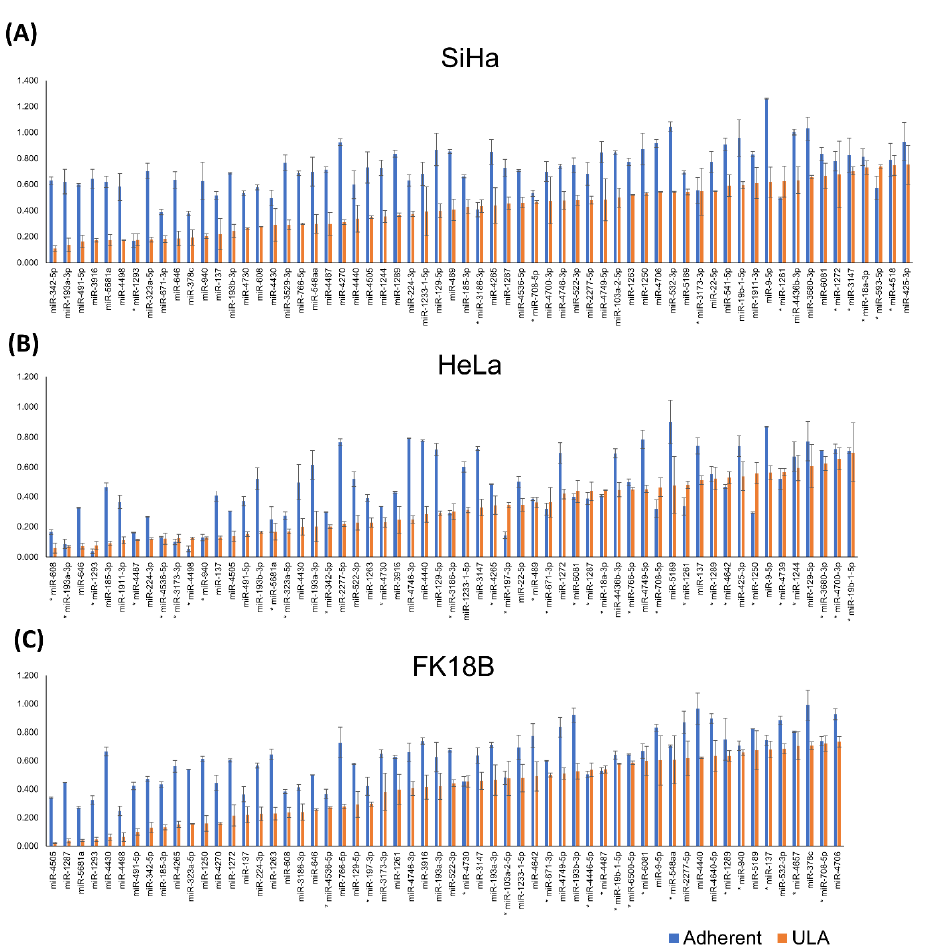
Figure 3. Validated miRNA mimics reducing growth on ULA plates. Cell viability results in adherent (blue) and ULA (orange) plates of validated miRNAs in SiHa ( A ), HeLa ( B ), and FK18B ( C ) cells. miRNAs annotated with * show no difference between adherent and ULA according to the set threshold. miRNAs without * show higher growth reduction in ULA plates than adherent plates and are referred to as the “ULA-norm-Ad”. The error bars represent the standard errors of two measurements.